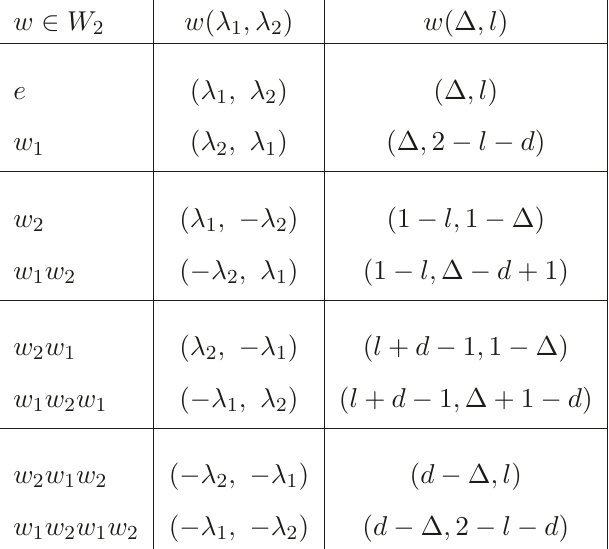
The final column of table 1 will be explained in section 4. It describes the asymptotic